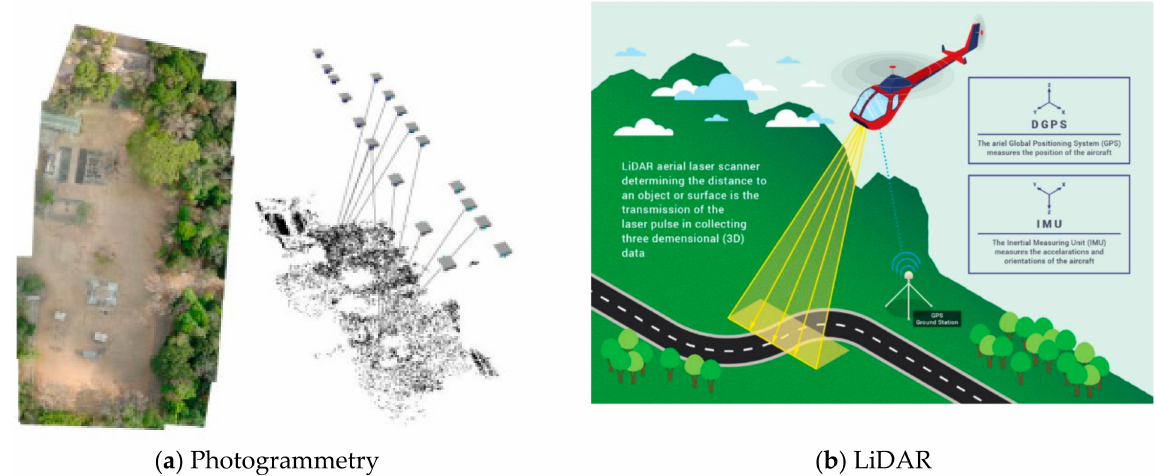
Figure 6. Surveying images of ( a ) photogrammetry [18] and ( b ) LiDAR [19].